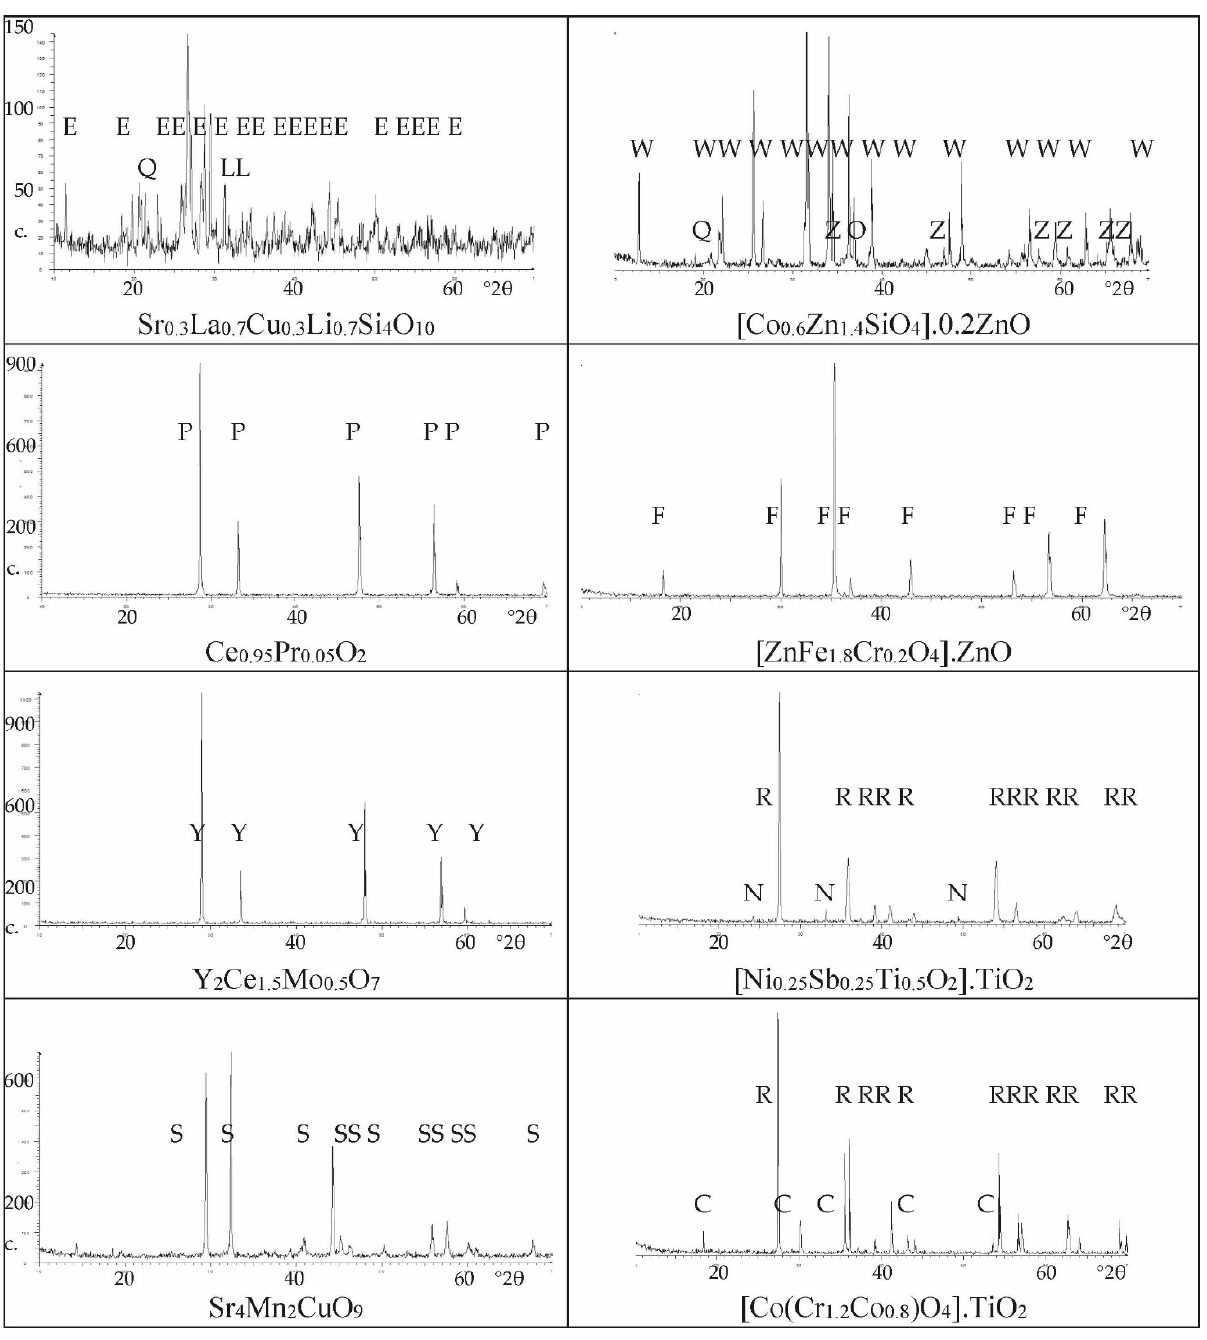
Figure 2. XRD patterns of powders. CRYSTALLYNE PHASES: E (wesselsite SrCuSi 4 O 10 ), L (La 2 O 3 ), W (willemite Zn 2 SiO 4 , Q (quartz), Z (ZnO), O (Co 3 O 4 ), P (CeO 2 ) F (Franklinite ZnFe 2 O 4 ), Y (Y 2 Ce 2 O 7 ), R (rutile), N (NiTiO 3 ), S (Sr 4 Mn 2 CuO 9) and C (CoCr 2 O 4